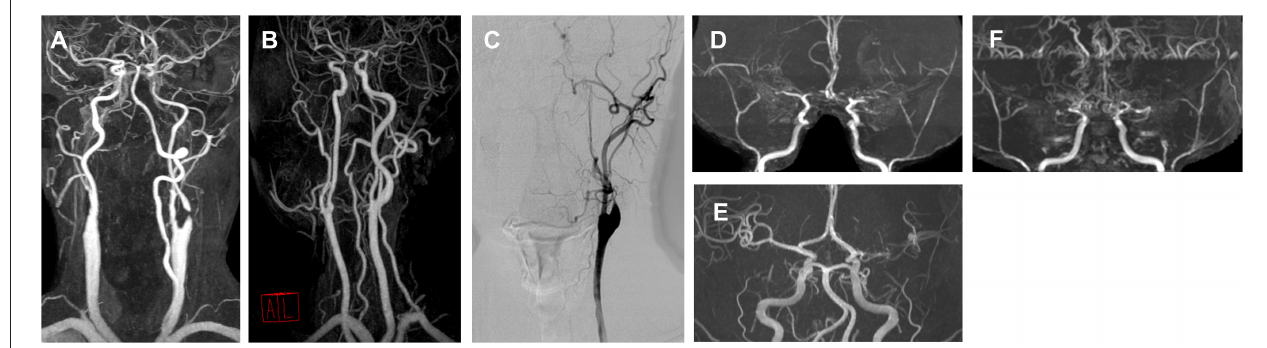
FIGURE 3 | Angiography of representative cases for each movement disorder phenotype. (A) A 76-year-old male with right hemichorea and contralateral proximal internal carotid artery (ICA) stenosis. (B) A 57-year-old male with limb-shaking of the left arm and contralateral proximal ICA stenosis. (C) A 56-year-old male with a myoclonus of the right arm and leg and contralateral proximal ICA stenosis. (D) A 24-year-old male with left arm dystonia and moyamoya disease. (E) A 46-year-old female with right hemiparkinsonism and contralateral middle cerebral artery (MCA) stenosis. (F) A 28-year-old female with a mixed phenotype (left hemichorea and hemidystonia) and moyamoya